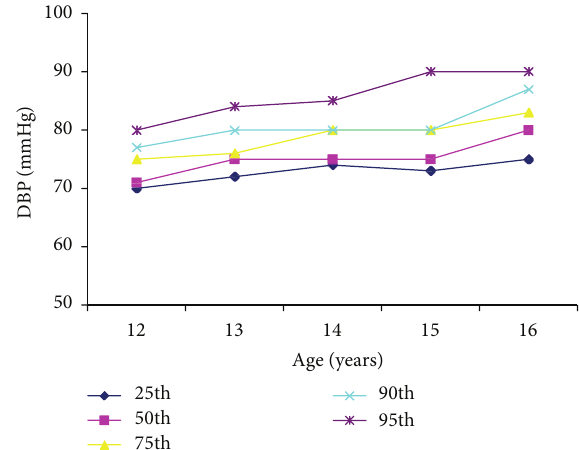
Figure 2: Percentile distribution of diastolic blood